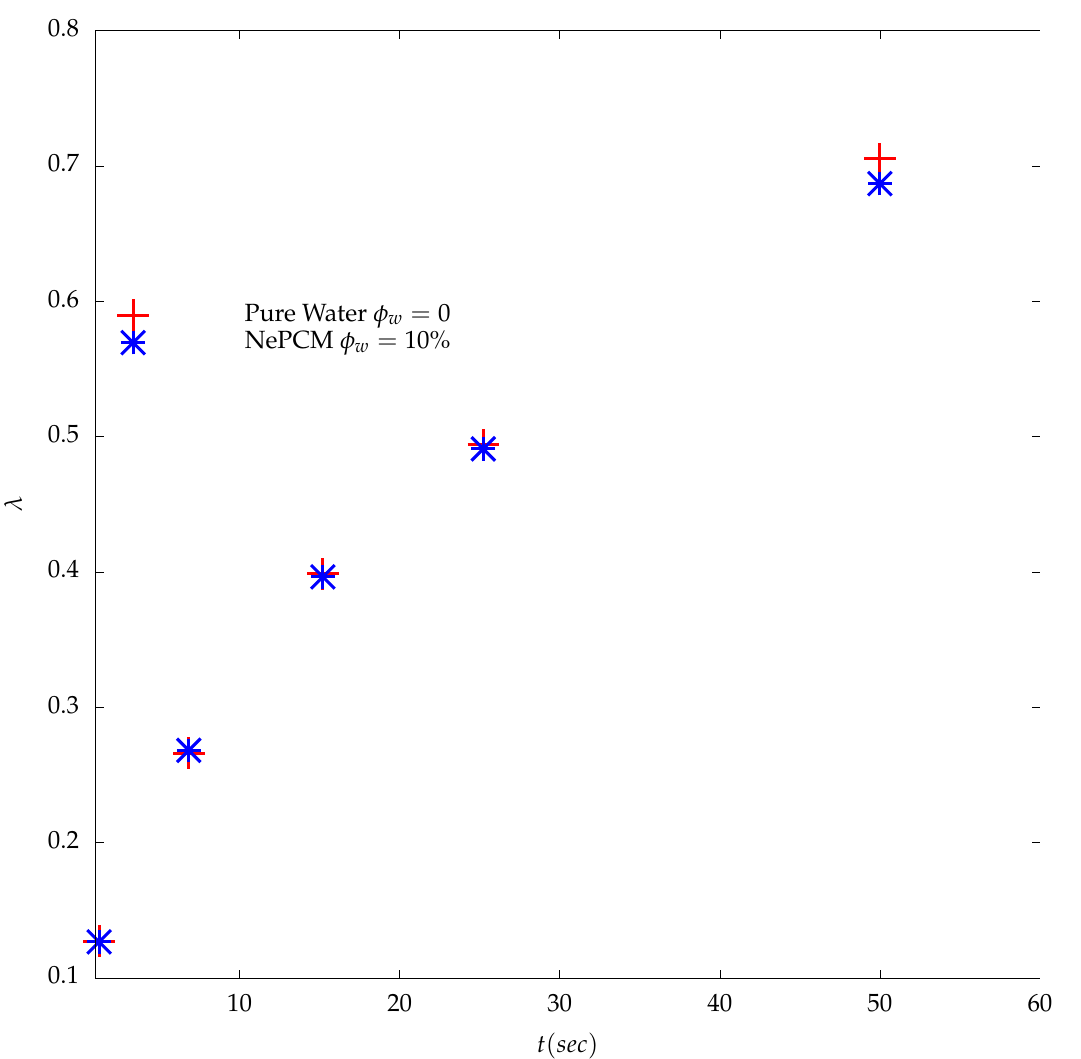
Figure 6. The temporal variation of the average liquid fraction for the case of pure water ( φ w = 0.0), and NePCM with φ =